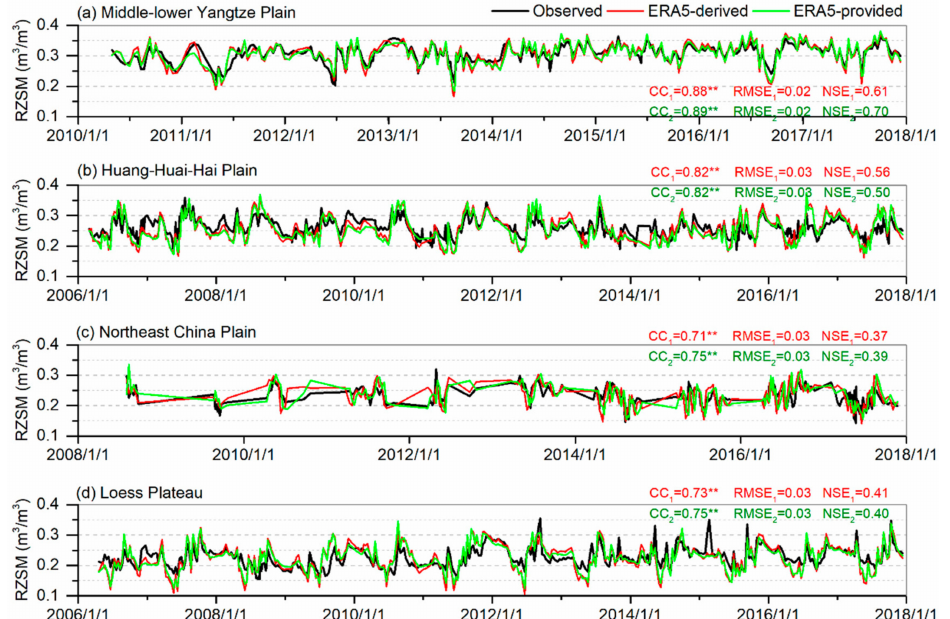
Figure 6. Temporal comparison of ERA5-derived RZSM compared to the in-situ ground observations and ERA5-provided RZSM in ( a ) Middle-lower Yangtze Plain, ( b ) Huang-Huai-Hai Plain, ( c ) North- east China Plain, and ( d ) Loess Plateau. (Herein, CC, RMSE, and NSE indicates the performance metrics of ERA5-derived (in red) and -provided (in green) RZSM against the observed RZSM series; and ** indicates significant correlation at p < 0.001).